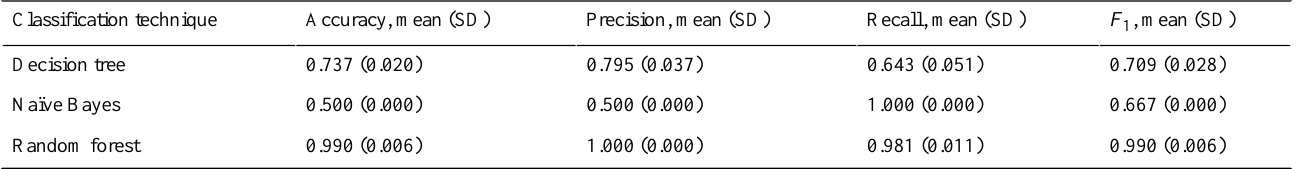
Table 2. Classification of the Repeatable Battery for the Assessment of Neuropsychological Status score performance measures when models were trained with 10-fold cross-validation (training set size=2152).